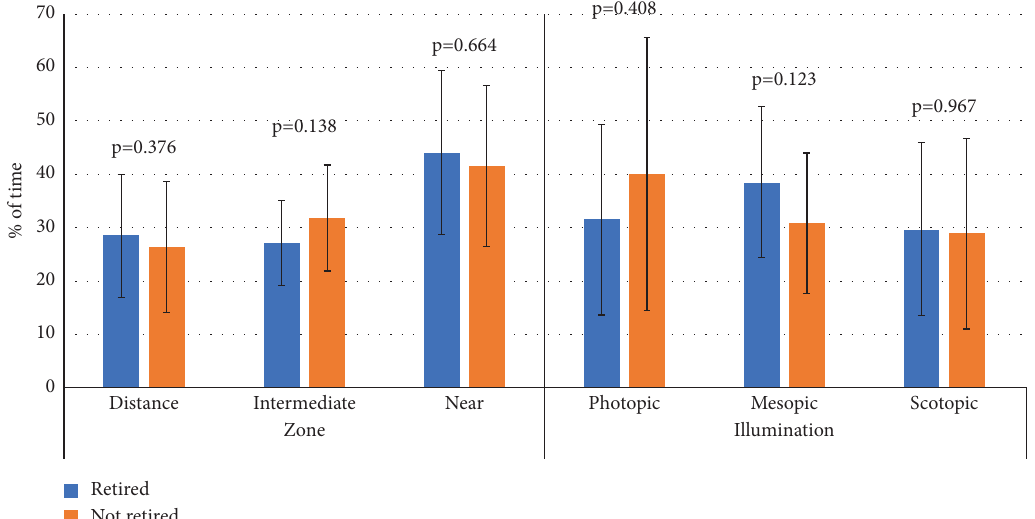
Figure 5: Mean percentages of time dedicated to distance, intermediate, and near vision and to activities performed under photopic, mesopic, and scotopic conditions in retired and not retired